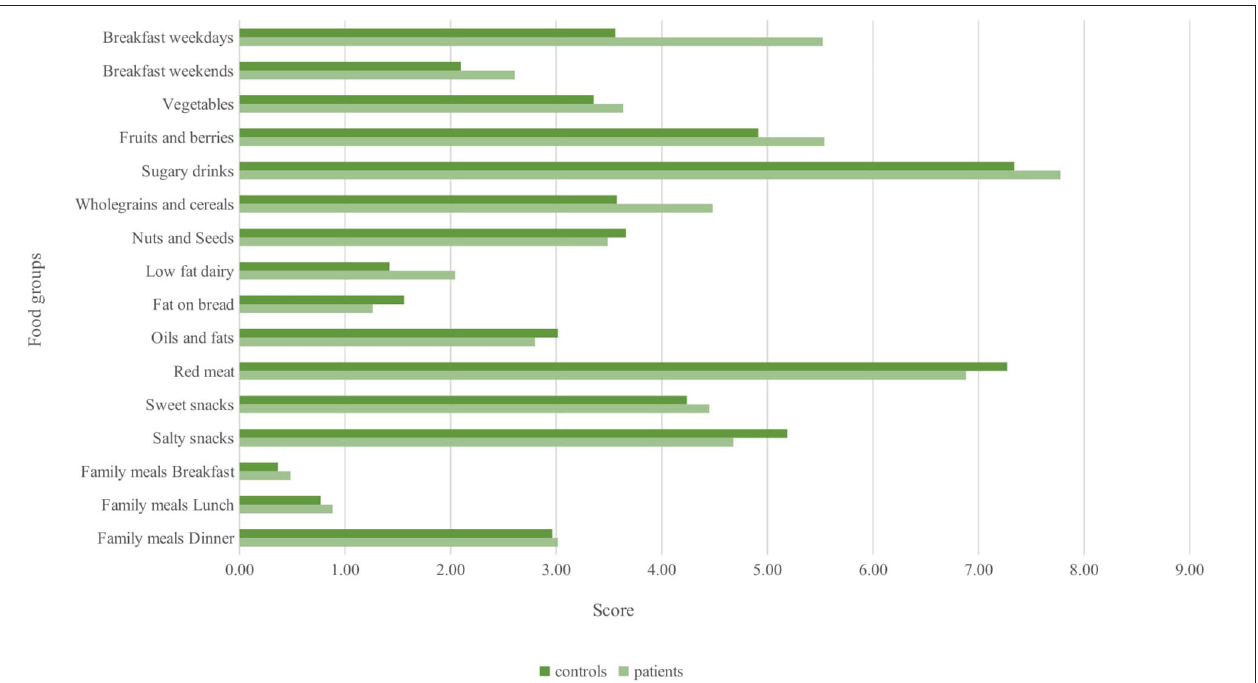
FIGURE 2 | Comparison between T1D patients and controls of items included in Feel4Diabetes healthy